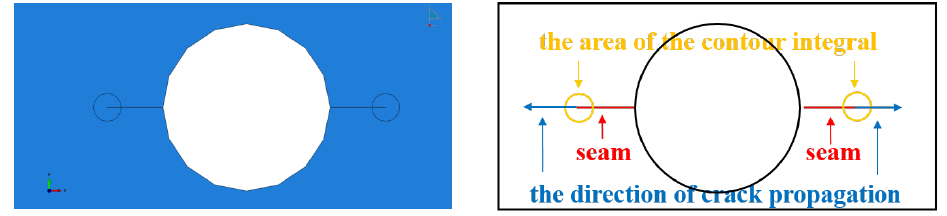
Figure 4. Hole crack definition model